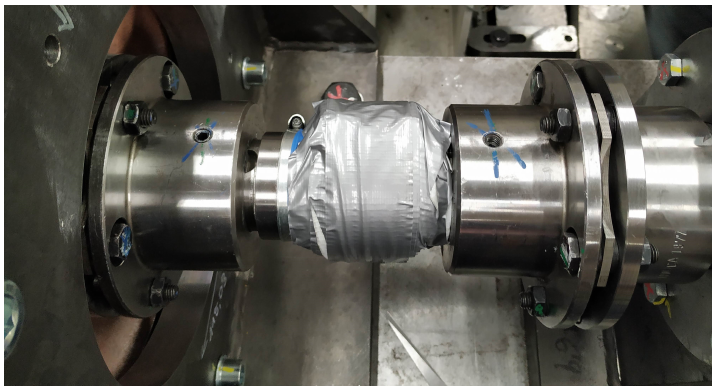
Figure 7. Recording unit mounted on the input shaft